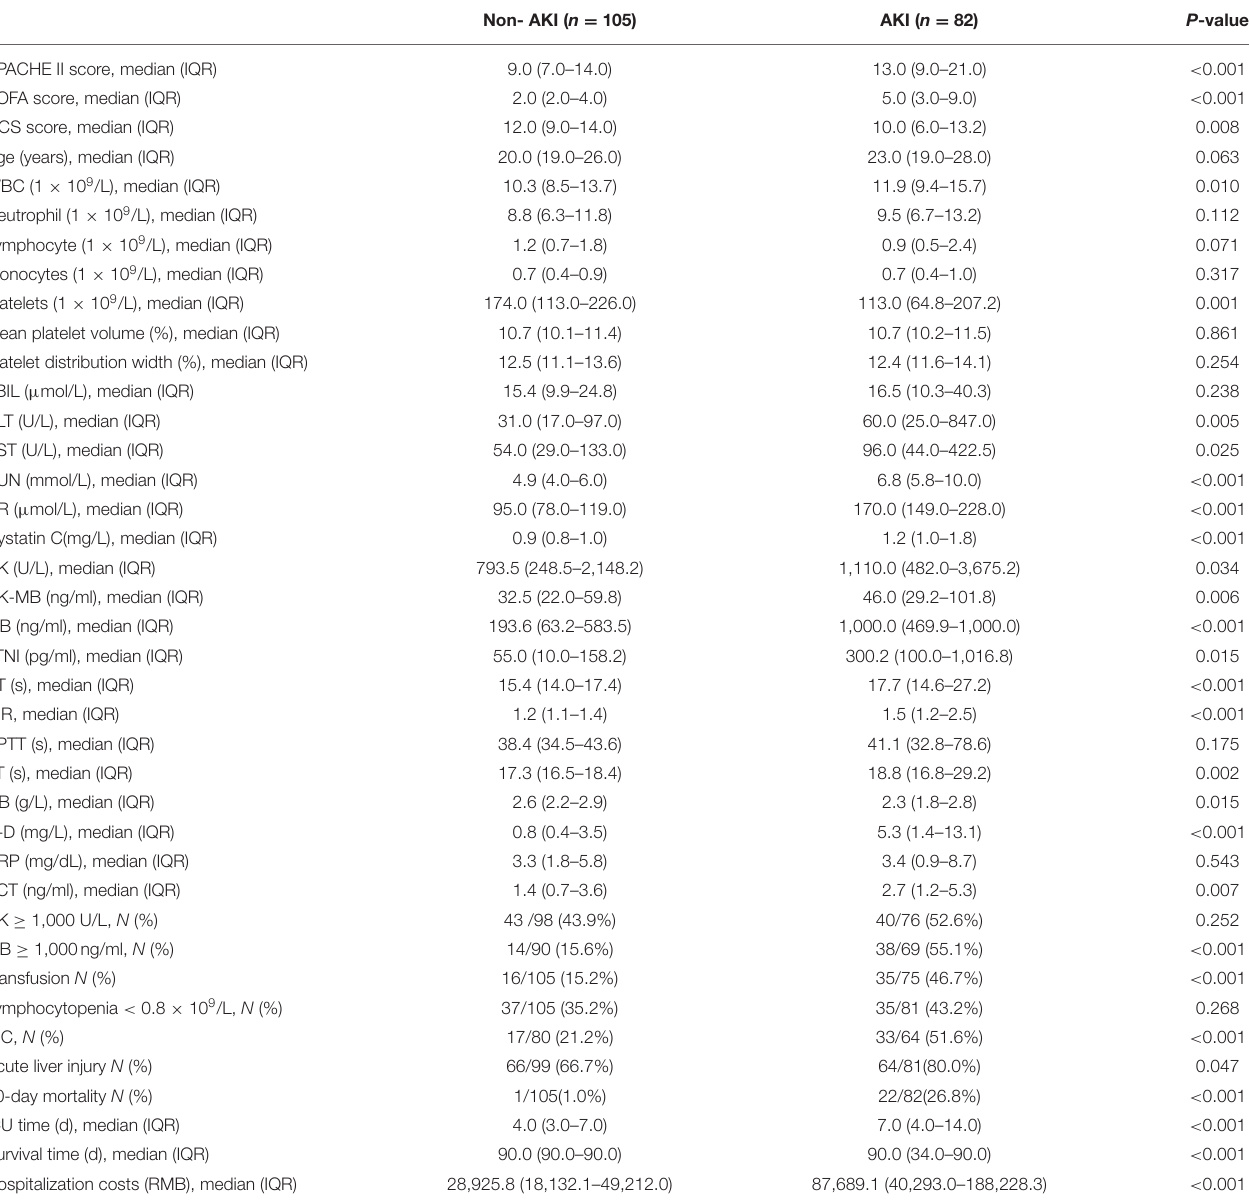
TABLE 1 | Comparisons of clinical characteristics between AKI and non-AKI patients with